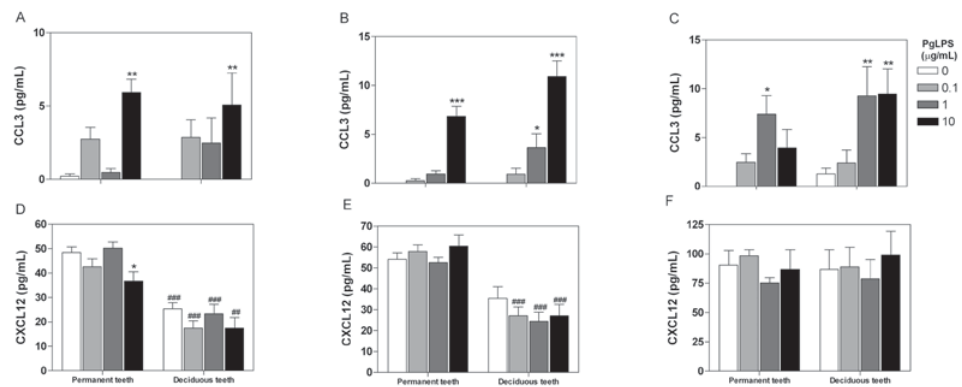
Figure 3- (cid:2)<(cid:6)(cid:12)(cid:15)(cid:18)(cid:7)(cid:8)(cid:10)(cid:12)(cid:13)(cid:2)(cid:12)(cid:14)(cid:2)(cid:7)(cid:4)(cid:9)(cid:25)(cid:12)=(cid:10)(cid:13)(cid:9)(cid:21)(cid:2)(cid:20)(cid:22)(cid:2)(cid:15)(cid:10)(cid:14)(cid:14)(cid:9)(cid:6)(cid:9)(cid:13)(cid:8)(cid:2)(cid:21)(cid:18)(cid:20)(cid:8)(cid:22)(cid:17)(cid:9)(cid:21)(cid:2)(cid:12)(cid:14)(cid:2)(cid:15)(cid:9)(cid:13)(cid:8)(cid:5)(cid:16)(cid:2)(cid:17)(cid:18)(cid:16)(cid:17)(cid:2)(cid:19)(cid:20)(cid:6)(cid:12)(cid:20)(cid:16)(cid:5)(cid:21)(cid:8)(cid:21)(cid:24)(cid:2)(cid:3)(cid:18)(cid:16)(cid:8)(cid:18)(cid:6)(cid:9)(cid:15)(cid:2)(cid:15)(cid:9)(cid:13)(cid:8)(cid:5)(cid:16)(cid:2)(cid:17)(cid:18)(cid:16)(cid:17)(cid:2)(cid:19)(cid:20)(cid:6)(cid:12)(cid:20)(cid:16)(cid:5)(cid:21)(cid:8)(cid:21)(cid:2)(cid:14)(cid:6)(cid:12)(cid:25)(cid:2) (cid:17)(cid:9)(cid:6)(cid:25)(cid:5)(cid:13)(cid:9)(cid:13)(cid:8)(cid:2)(cid:26)(cid:13)(cid:27)8(cid:29)(cid:2)(cid:5)(cid:13)(cid:15)(cid:2)(cid:15)(cid:9)(cid:7)(cid:10)(cid:15)(cid:18)(cid:12)(cid:18)(cid:21)(cid:2)(cid:26)(cid:13)(cid:27)$(cid:29)(cid:2)(cid:8)(cid:9)(cid:9)(cid:8)(cid:4)(cid:2)(cid:30)(cid:9)(cid:6)(cid:9)(cid:2)(cid:21)(cid:8)(cid:10)(cid:25)(cid:18)(cid:16)(cid:5)(cid:8)(cid:9)(cid:15)(cid:2)(cid:20)(cid:22)(cid:2) P. gingivalis (cid:2)><?(cid:2)(cid:5)(cid:8)(cid:2)(cid:8)(cid:4)(cid:9)(cid:2)(cid:10)(cid:13)(cid:15)(cid:10)(cid:7)(cid:5)(cid:8)(cid:9)(cid:15)(cid:2)(cid:7)(cid:12)(cid:13)(cid:7)(cid:9)(cid:13)(cid:8)(cid:6)(cid:5)(cid:8)(cid:10)(cid:12)(cid:13)(cid:21)(cid:2)(cid:26)(cid:13)(cid:27)G(cid:29)(cid:24)(cid:2) Cell supernatants were collected after 1 (A and D), 6 (B and E) and 24 (C and F) h. Production of CCL3 (A, B and C) and CXCL12 (D, E and F) was detected by means of ELISA. (*) p<0.05; (**) p<0.01 and (***) p<0.001 in comparison with culture medium alone (0). (##) p<0.01 and (###) p<0.001 in comparison with the other cellular subtype at the same experimental